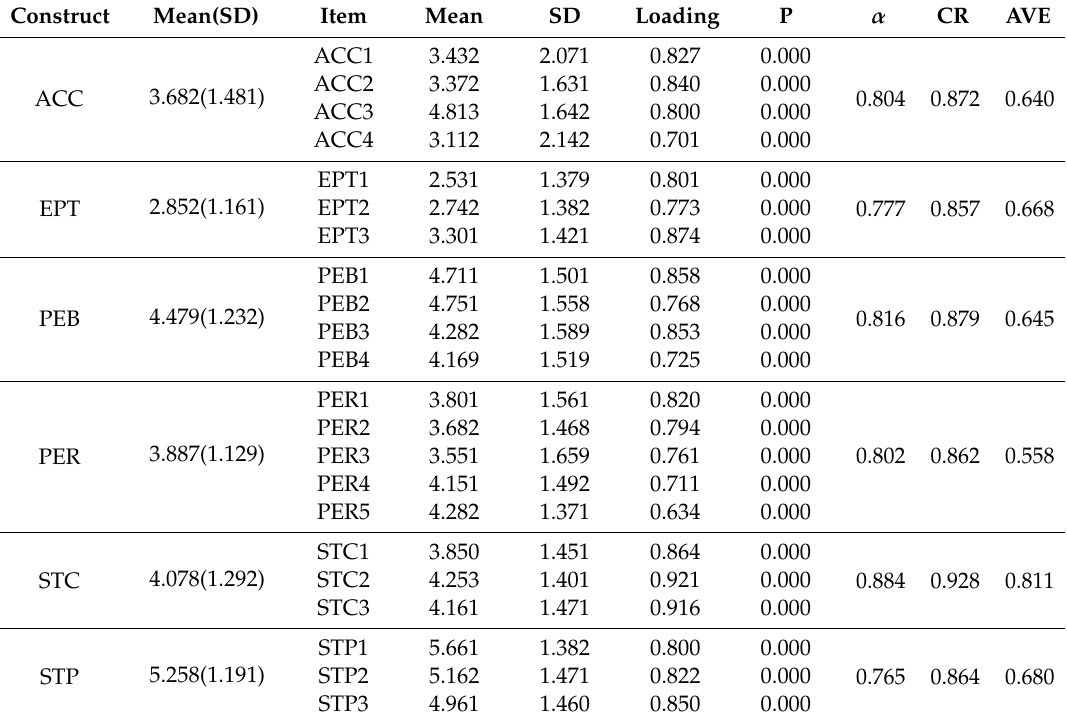
Table 3. Confirmatory factor analysis results.